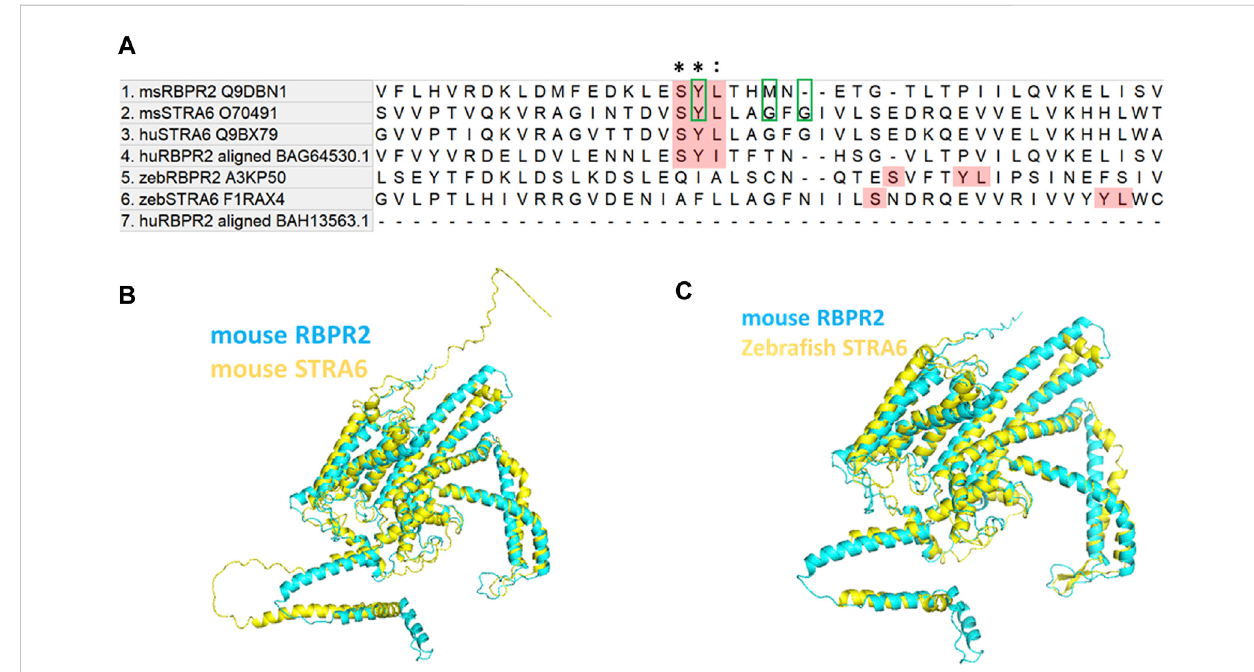
FIGURE 1 Proposed RBP4 binding residues on RBPR2 are conserved across species. (A) Proposed RBP4 binding residues on RBPR2 (highlighted Red; amino acid residues S294, Y295 and L296) occurs in exon 11 of mouse RBPR2 (Alapatt et al., 2013). The multiple sequence alignment of mouse and human STRA6, RBPR2 sequences shows conserved residues (Tamura et al., 2021). * indicates conserved residues of the RBP4 binding motif; (colon) indicates strongly similar properties. The previously proposed RBP4 binding residues on mouse STRA6 (Tyrosine Y336, Glycine G340, and Glycine G342) are highlighted with green box. The zebra fi sh STRA6 and RBPR2 sequence were not highly conserved but surprisingly had an exact topological feature alignment with the mouse sequence to extracellular region of the receptor (https://www.uniprot.org/uniprotkb/Q9DBN1/entry#sequences). (B,C) Computer modeling and structure homology between RBPR2 (blue) and STRA6 (yellow)